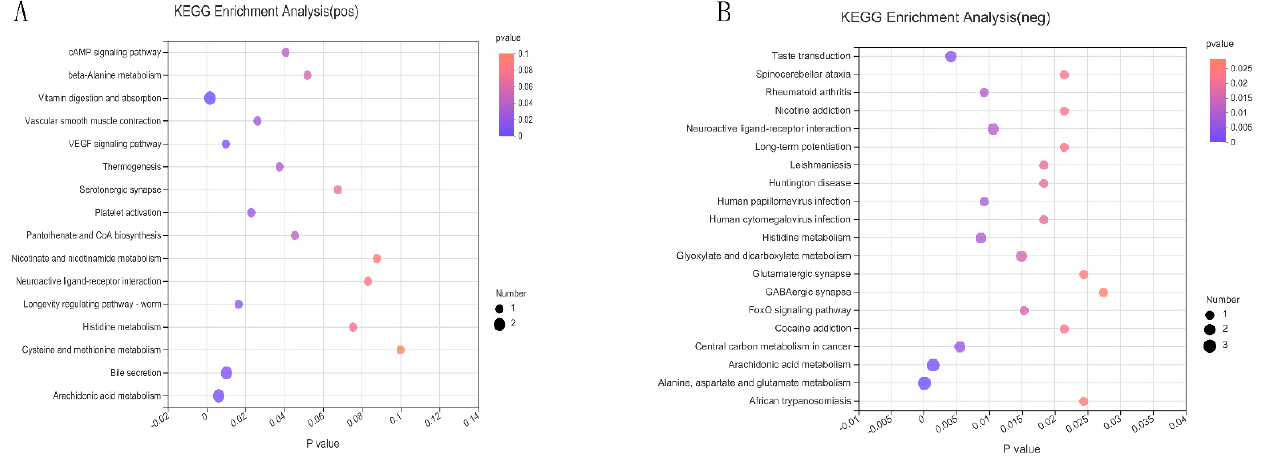
Figure 8. Differential metabolomic pathways of differentially expressed metabolites according to the KEGG database matched results under positive ion mode ( A ) and negative ion mode ( B ), re- spectively ( n = 6). The size of each point represents the metabolite number, and the color represents p